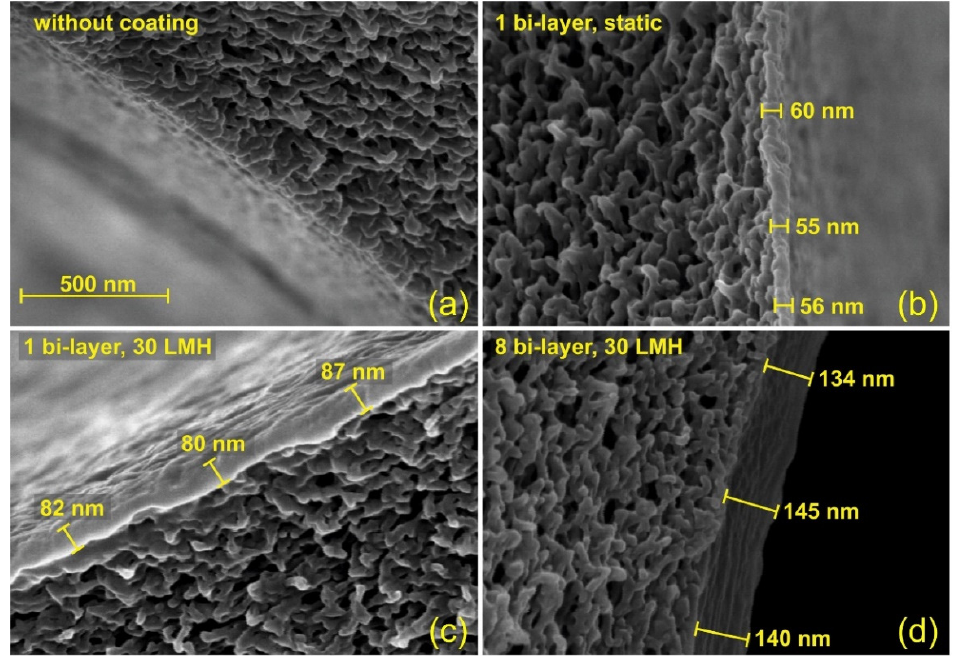
Figure 2. Scanning electron microscopy images of 4 different membranes: ( a ) Without coating, ( b ) 1 bilayer coated in static mode with an adsorption time of 10 min, ( c ) 1 bilayer coated in dynamic mode at 30 LMH for 10 min, ( d ) 8 bilayers coated in dynamic mode at 30 LMH for 10 min. Reprinted from [38], with permission from Elsevier.